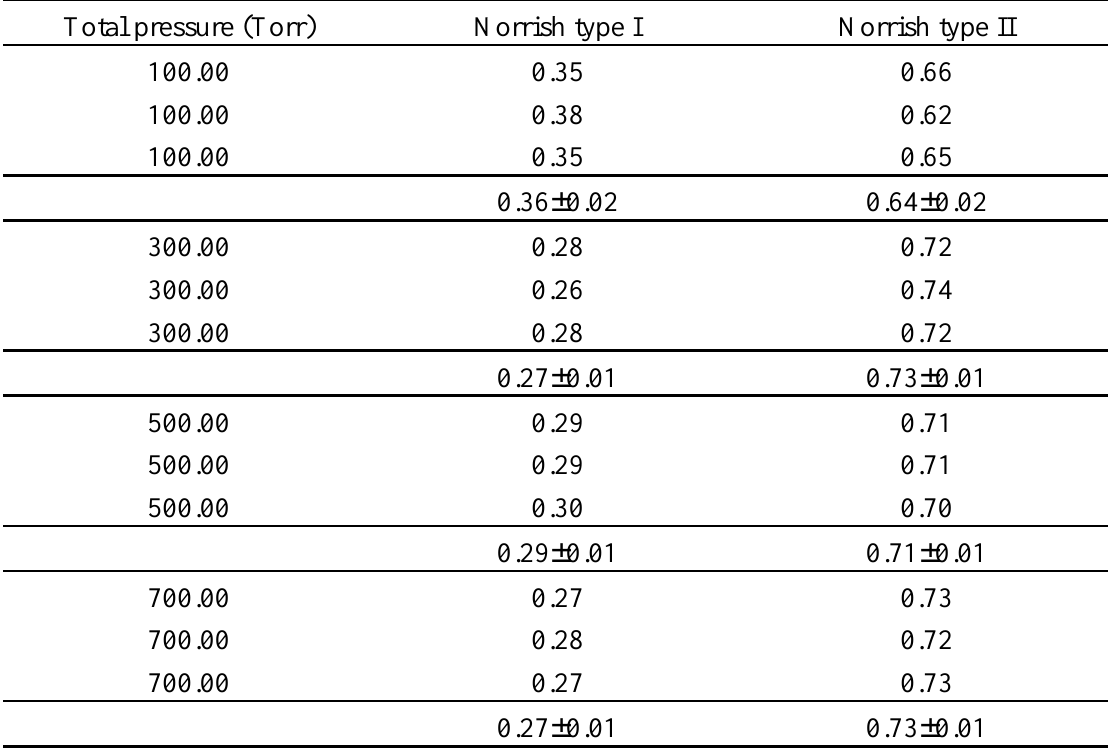
Table 1. Probabilities for n -hexanal molecule to undergo different decomposition channels, TL12 lamps (errors are represented by experimental scatter).